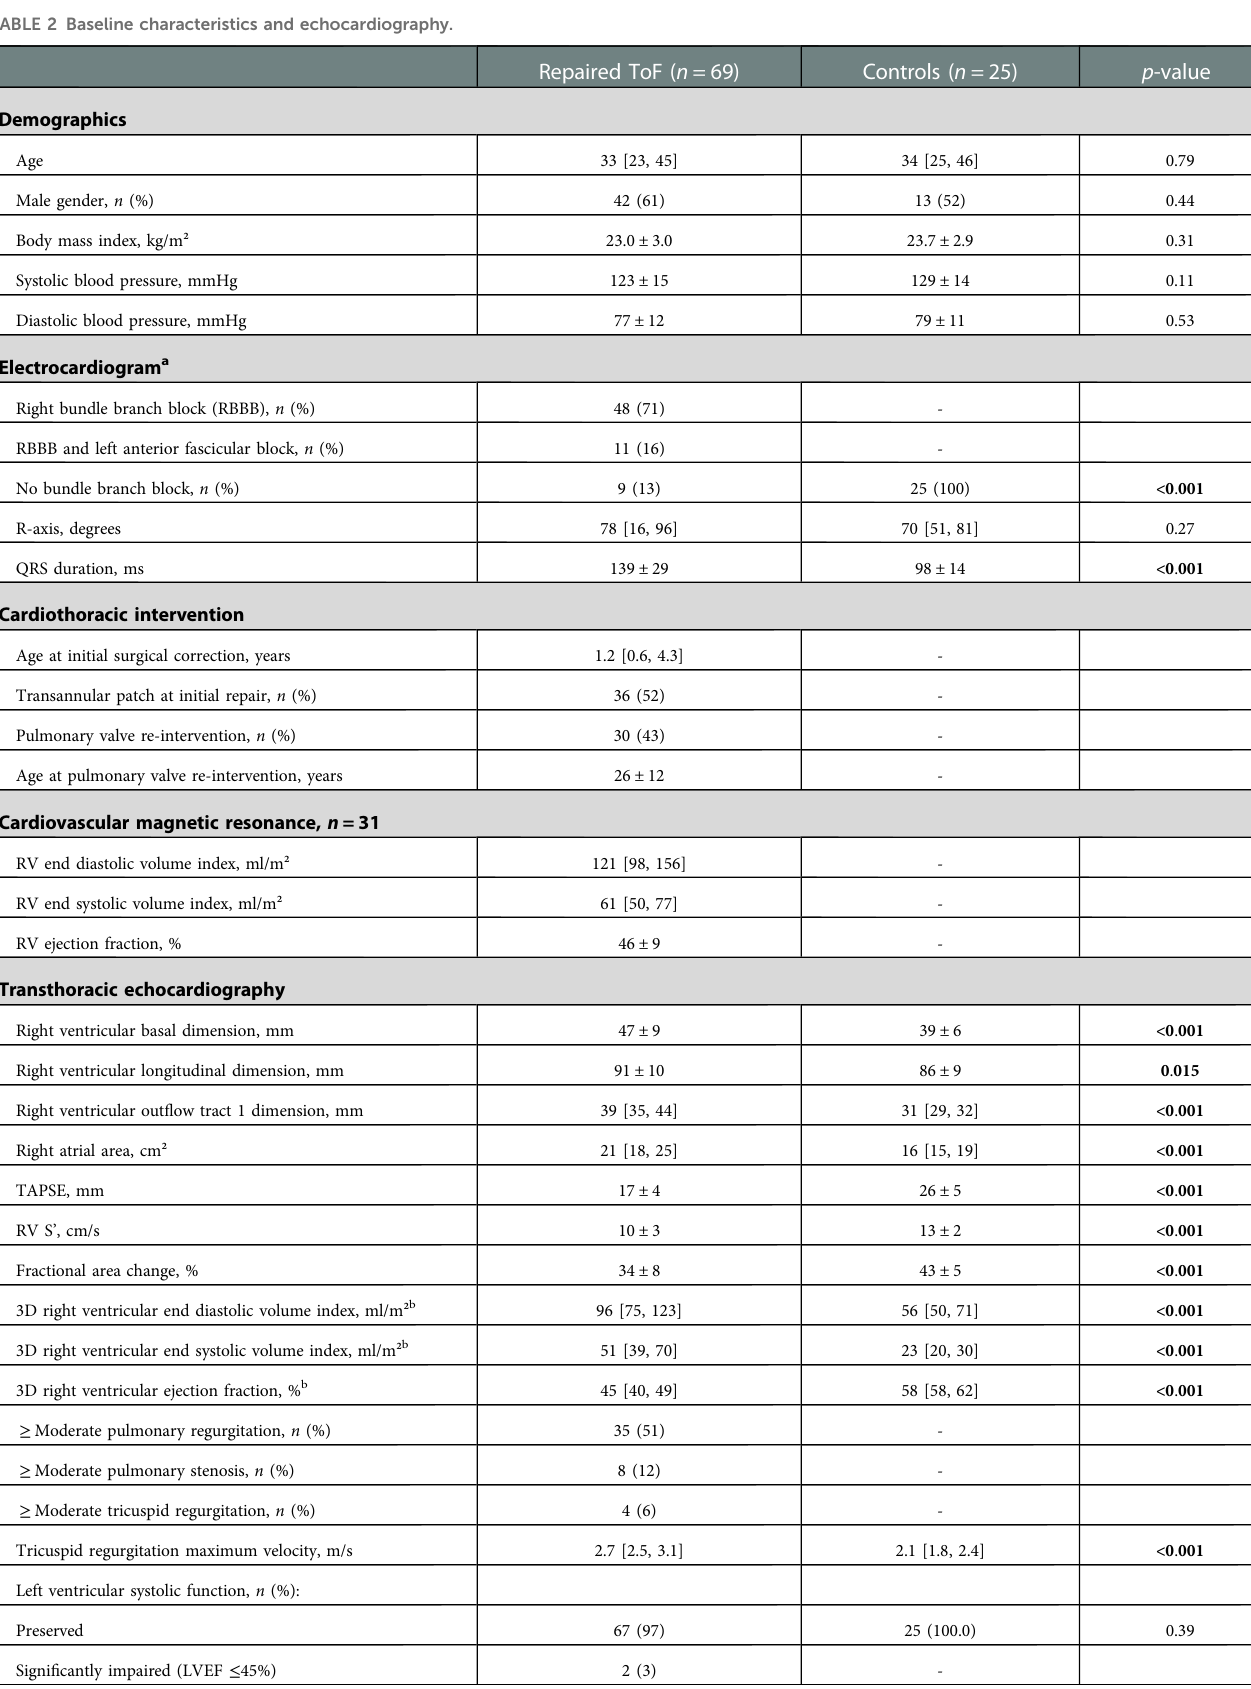
TABLE 2 Baseline characteristics and